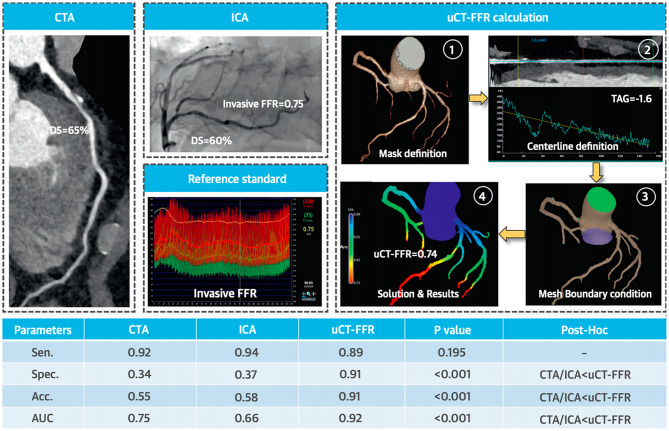
Functional significance of proximal left anterior descending artery stenosis. Adapted from Tang et al. (65). Permission obtained from the publisher.